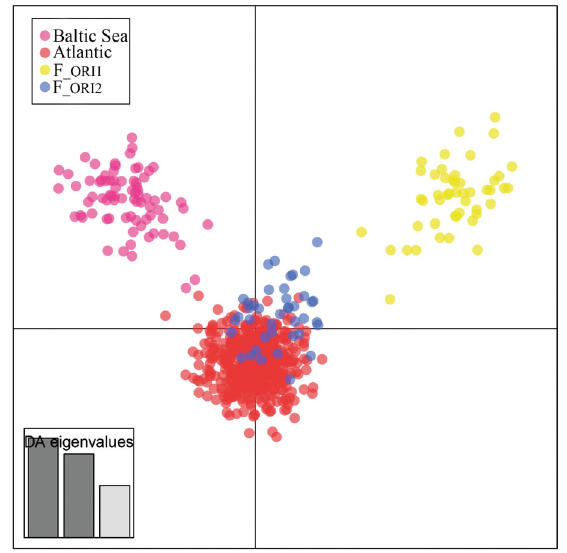
Fig. 3. Clustering of pure wild and farmed (see Table 1) sam- ples of turbot genotyped for 755 SNPs using